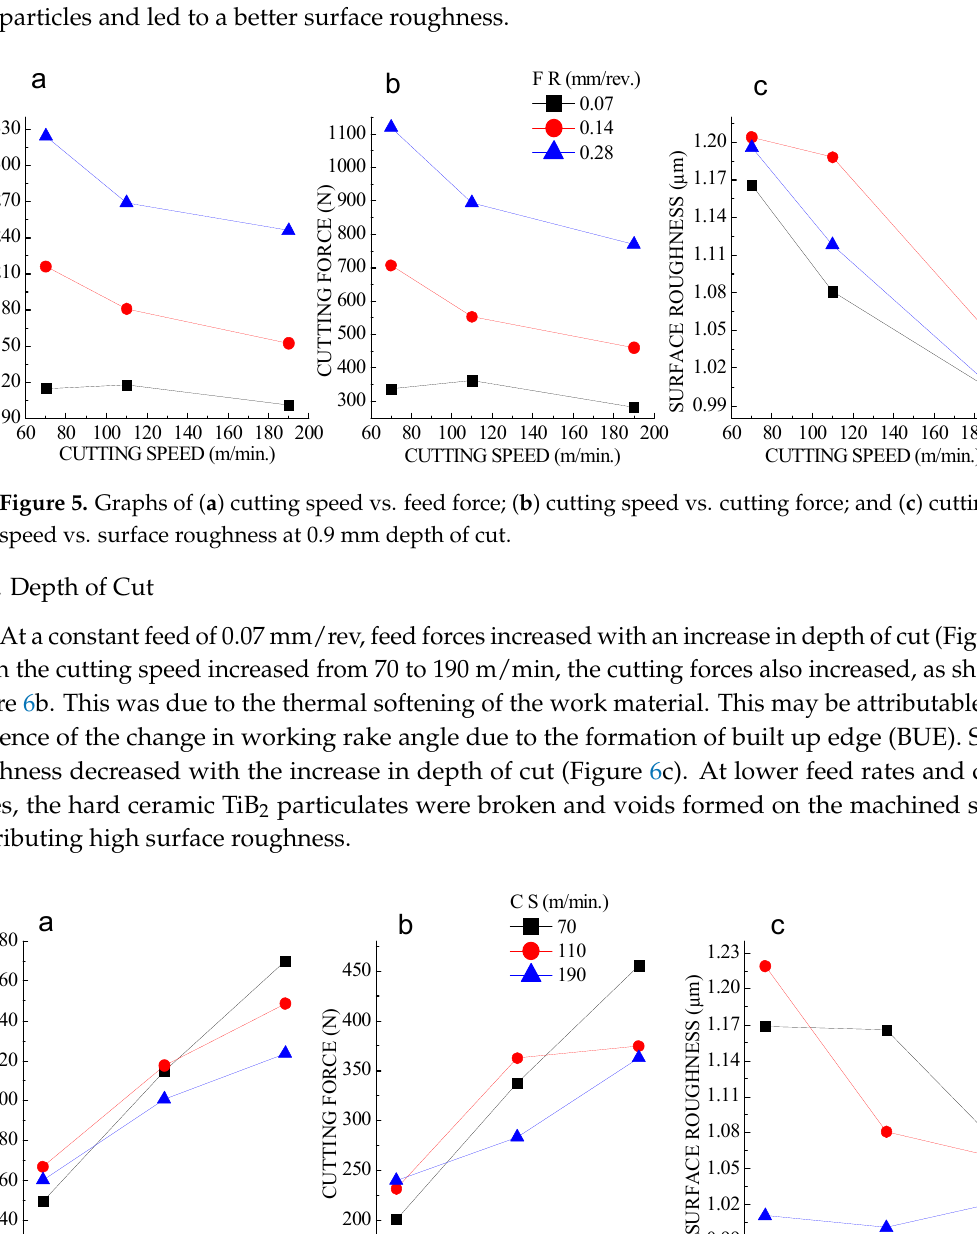
Figure 4. Graphs of ( a ) feed rate vs. feed force; ( b ) feed rate vs. cutting force; and ( c ) feed rate vs. surface roughness at 190 m/min cutting speed .